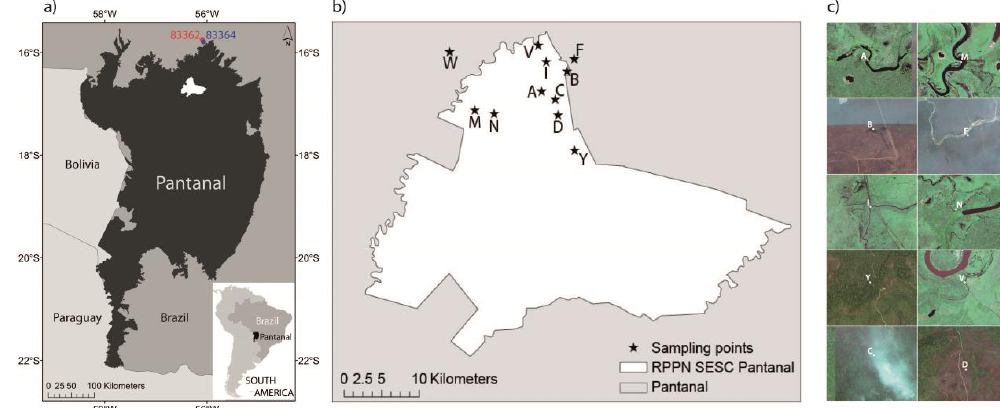
Figure 1. (a) Location of study area (RPPN SESC Pantanal, white background) in northern part of Brazilian Pantanal wetland of South Figure 1: a) Location of study area (RPPN SESC Pantanal, white background) in northern 3 America with Cuiabá Airport station (83362) and class A pan location (Padre Ricardo Remetter Station 83364); (b) location of sampling part of Brazilian Pantanal wetland of South America with Cuiabá Airport station (83362) and 4 points; (c) studied water bodies (source: Google Class A pan location (Padre Ricardo Remetter Station 83364); b) Location of sampling 5 points; c) Studied water bodies (Source: Google Earth) 6